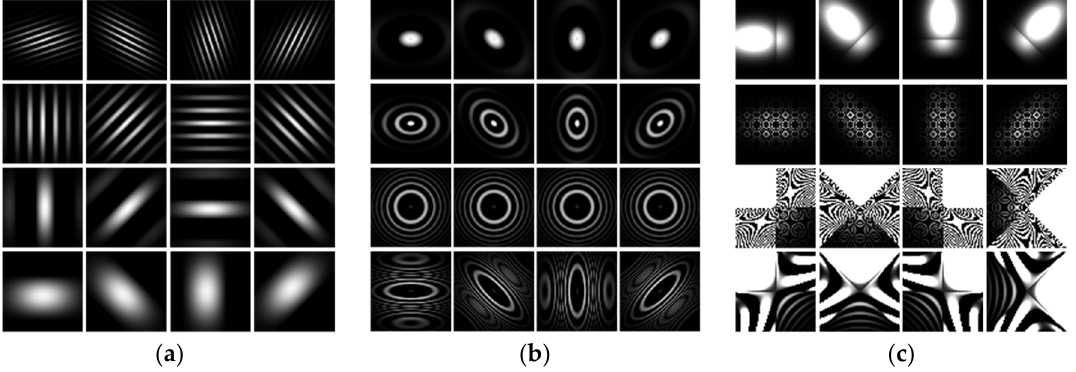
Figure 4. Improved two-dimensional (2D) Gabor filters with various shapes: ( a ) Conventional Gabor filters with oriented grating, ( b ) circular Gabor filters, and ( c ) more complicated Gabor filters.